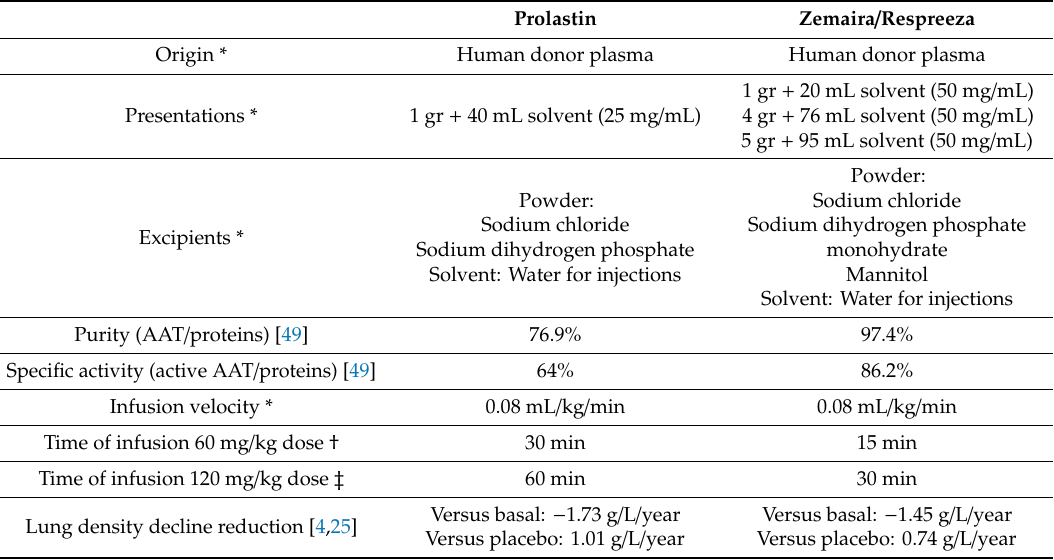
Table 2. Di ff erences between Prolastin and Zemaira /